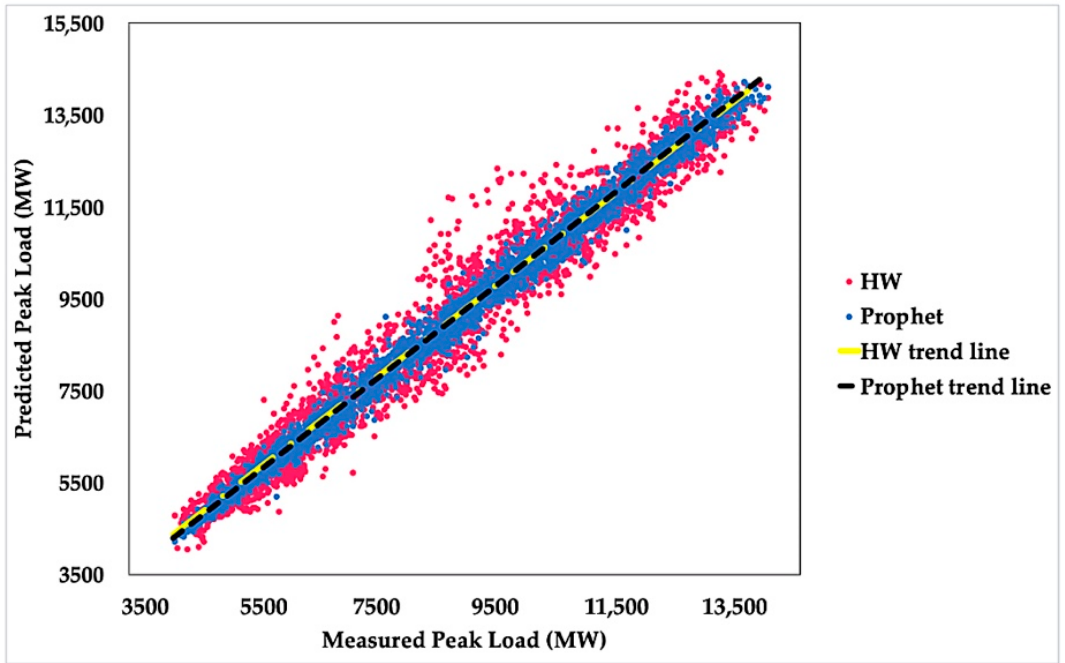
Figure 7. The coefficient of determination R 2 and the fitting characteristics of real and simulated data for both models.